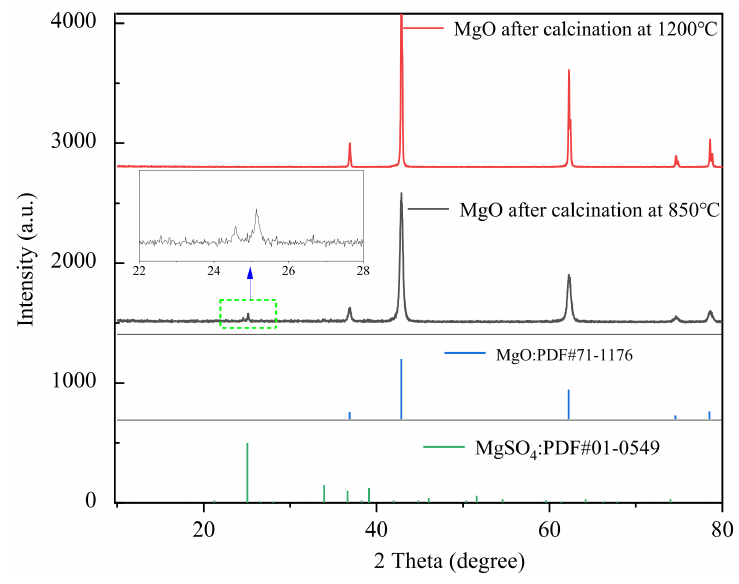
Figure 7. XRD patterns of MgO.